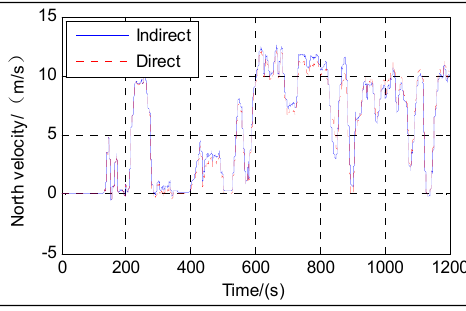
Figure 4. North velocity.